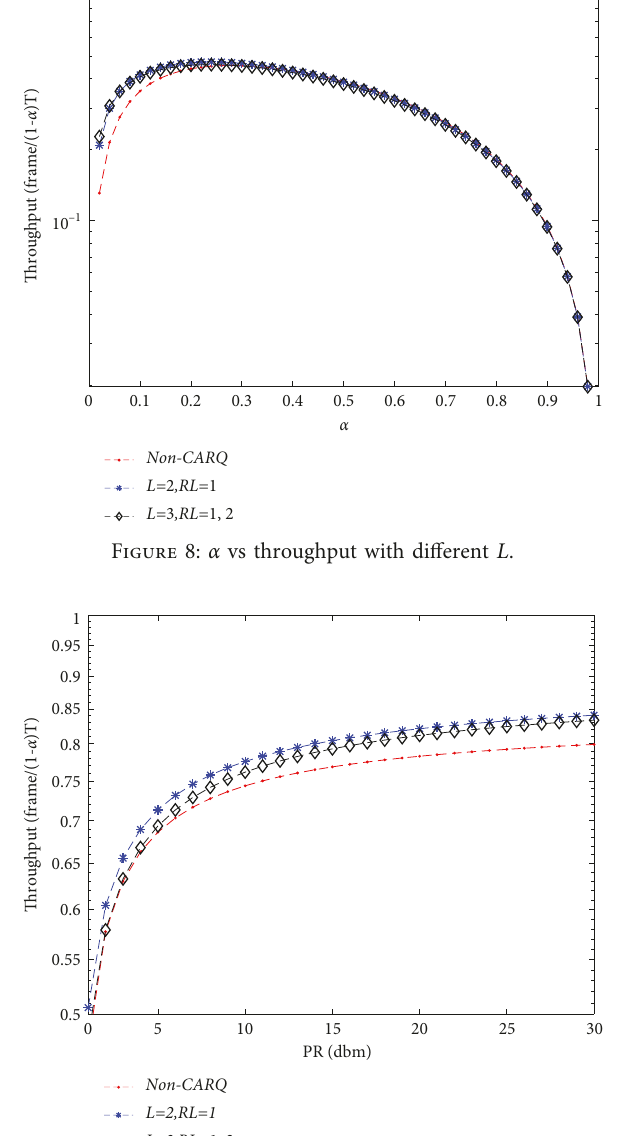
Figure 9: P R vs throughput with different